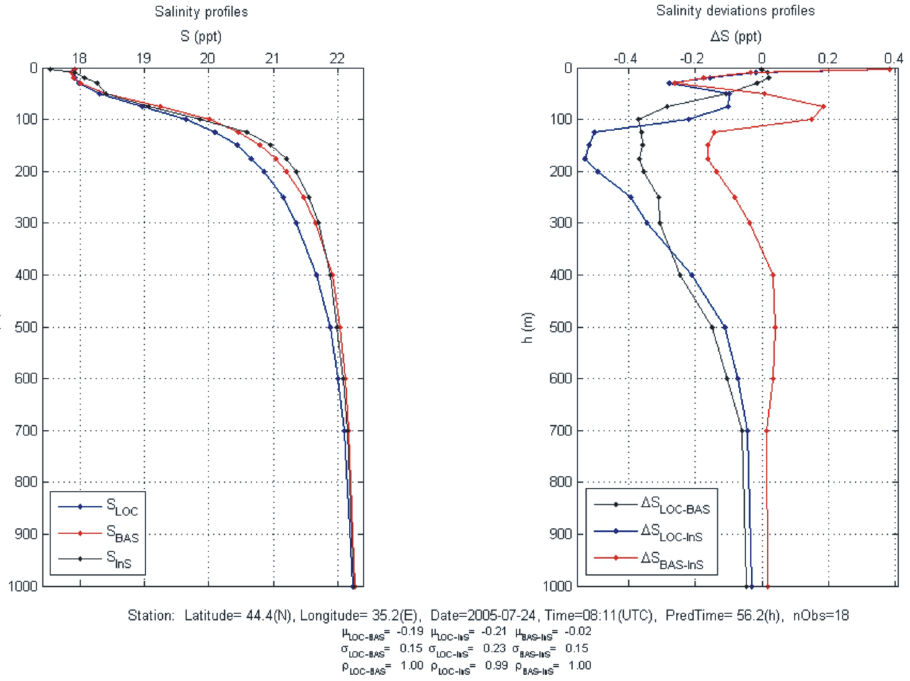
Fig. 12. The salinity profiles (left) derived from coastal model (blue), basin-scale model (red) and in-situ measurements (black) and the deviations of the local (blue) and basin-scale (red) models from observations and the difference between local and basin-scale models (right).